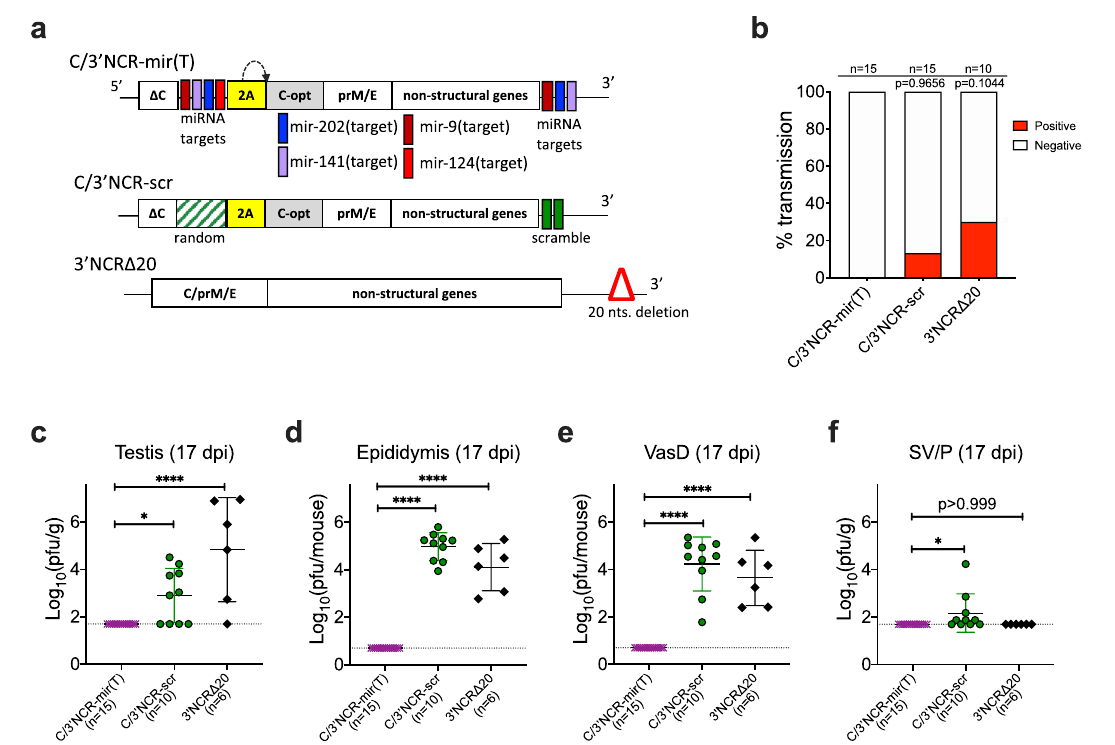
Fig. 7 Restriction of male-to-female transmissibility of the miRNA-targeted live-attenuated ZIKV vaccine candidate. a Schematic representation of viral genomes used in the study. b Rate of ST (%) of indicated viruses (determined as in Fig. 3a). Differences in the rates of ST between C/3 ′ NCR-mir(T) and control viruses were compared by two-tailed Fisher ’ s exact test with Bonferroni correction. c – f At 17 dpi, organs of MRS were dissected from mice participating in the ST experiment. Graphs show mean virus titer ± SD in the organs of AG129 mice. The dashed lines indicate the limit of virus detection: 1.7 log 10 pfu/g for testis and SV/P and 0.7 log 10 pfu/mouse for epididymis and vas deferens. Differences between viral titers in the organs of MRS were compared using one-way ANOVA with multiple comparison adjustment (Dunnett ’ s test). * p < 0.05; **** p <